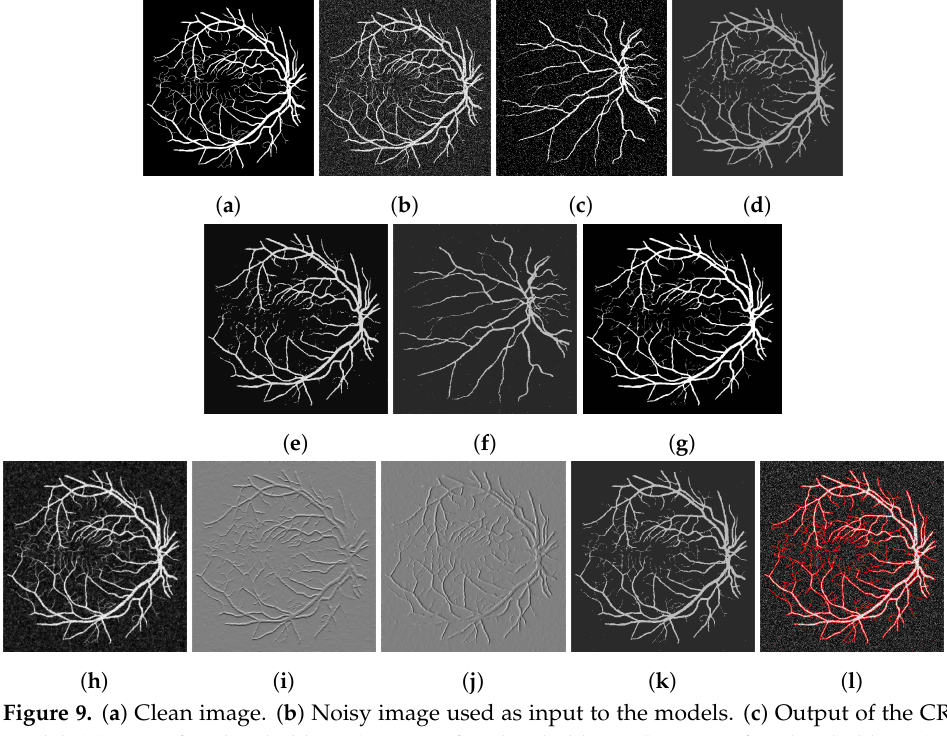
Figure 9. ( a ) Clean image. ( b ) Noisy image used as input to the models. ( c ) Output of the CRCV model. ( d ) CCZ after thresholding. ( e ) CNC after thresholding. ( f ) T-ROF after thresholding. ( g ) DL output. ( h ) Output g of our model. ( i ) Output G x of our model. ( j ) Output G y of our model. ( k ) Ours after thresholding. ( l ) Our contour.